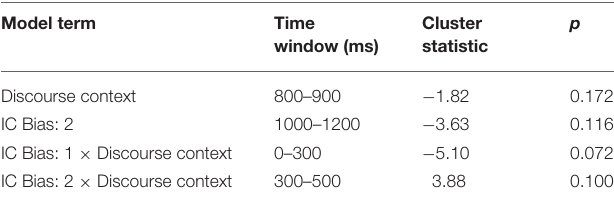
TABLE 3 | Experiment 2: cluster statistics for the model terms, the time window with which the cluster was associated and the proportion of the models that formed the empirical distribution which had a cluster statistic equal to or higher than (or lower than, if the cluster statistic had a negative sign) the cluster statistic found in the data for a given term (the p